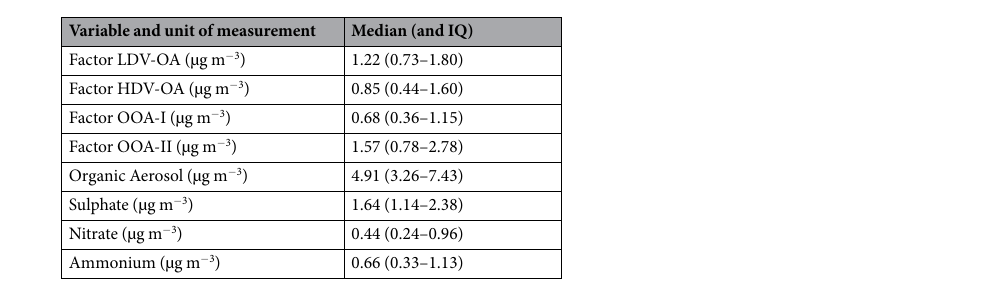
Table 2. Concentration of PMF factor loadings and ambient concentration of chemical species in the submicrometric size range. Measurement data has been averaged into 1-h bins, from similar statistics as Table